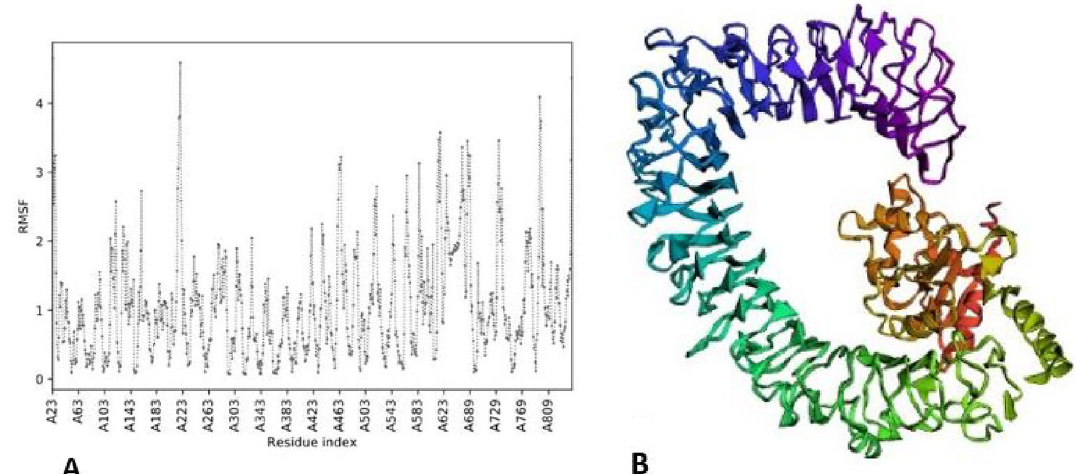
Figure 8. The molecular dynamics simulation of the vaccine-TLR5 docked complex. ( A ) The Root Mean Square Fluctuation (RMSF) plot of the protein vaccine structure demonstrates the fluctuations of MEV residues during the fast simulations. High degree fluctuation was identified in the residues at positions 219 and 617 in 4.58 Å and 3.57 Å. ( B ). The identified stable protein vaccine structure with fast flexibility simulations using the CABS-Flex